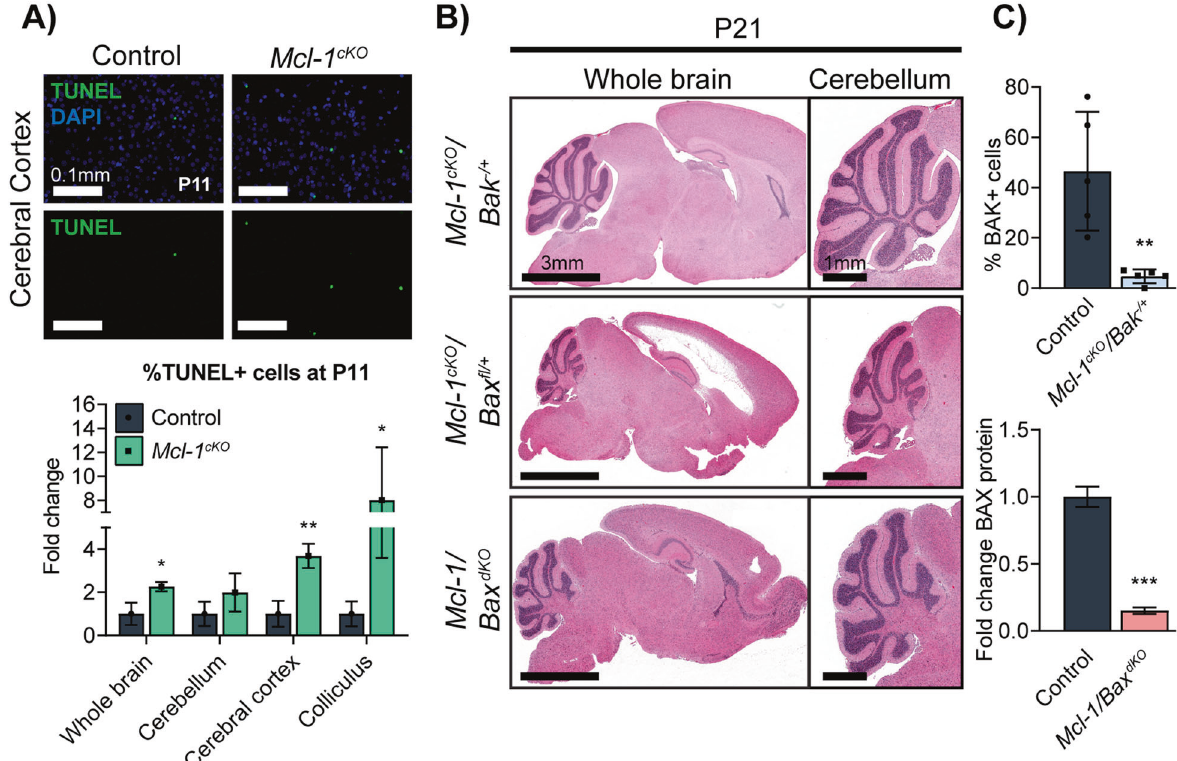
Fig. 3 Mcl-1 deletion causes white matter degeneration by increasing apoptosis. A TUNEL demonstrates increased cell death in Mcl-1 cKO brains. For cell counts, one sagittal section from each replicate was scanned at ×20 and TUNEL + cells were counted across the entire portion of each designated region that was contained within the section. All values are expressed as fold change in the number of TUNEL + cells per standardized anatomic region, relative to the mean for the replicate control samples. B Representative H&E sections show that heterozygous Bak co-deletion and homozygous Bax co-deletion both rescue the white matter loss with ventricular enlargement (*) and cerebellar abnormalities caused by Mcl-1 deletion. Rescues were assessed relative to affected Mcl-1 cKO (Fig. 1A) and Mcl-1/Bax fl / + brains. C Quanti fi cation of BAK immunohistochemistry in corpus callosum shows that heterozygous Bak deletion signi fi cantly reduces the number of BAK + cells. Quanti fi cation by detection of bioluminescence in western blot of whole cerebella shows that homozygous Bax deletion reduces BAX protein abundance. *, **, and *** denote p < 0.05, p < 0.01, and p < 0.001, respectively, relative to controls.